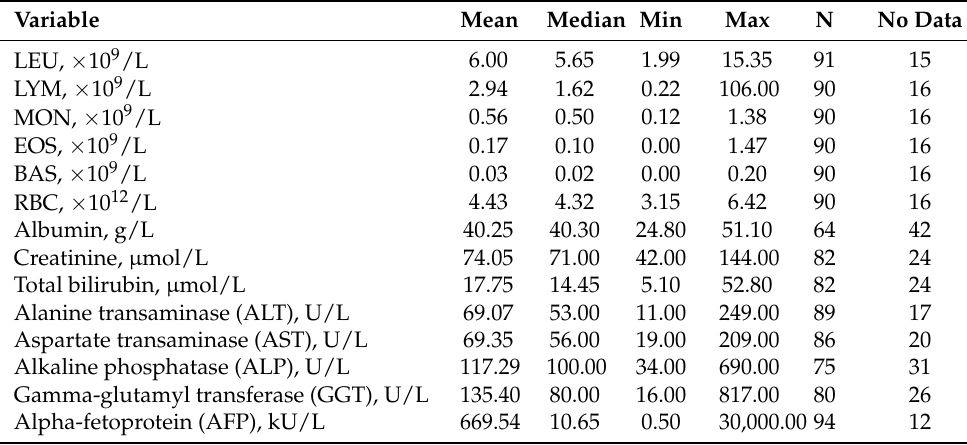
Table 2. Summary of the results of the preoperative blood